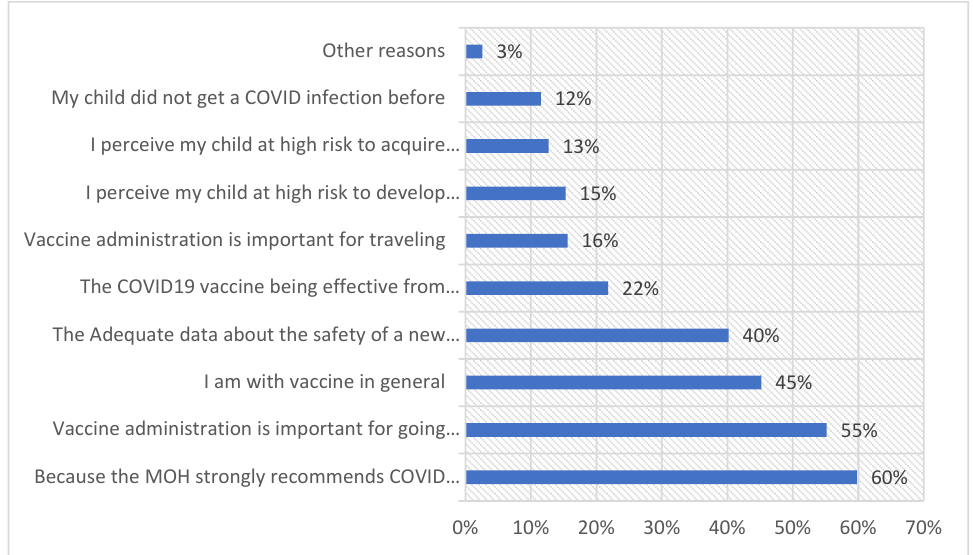
Figure 3. Reasons for vaccinating children against COVID-19 (n = 694). Almost 60% stated they vaccinated their children because of the MOH’s strong recommendation, 55.2% thought the vaccines were necessary for children to be able to go back to school, and almost 45.2% stated they agree with vaccines in general. In addition, 40.2% of them believed that there were sufficient data about the vaccine’s safety. Other reasons are shown in Figure 3.